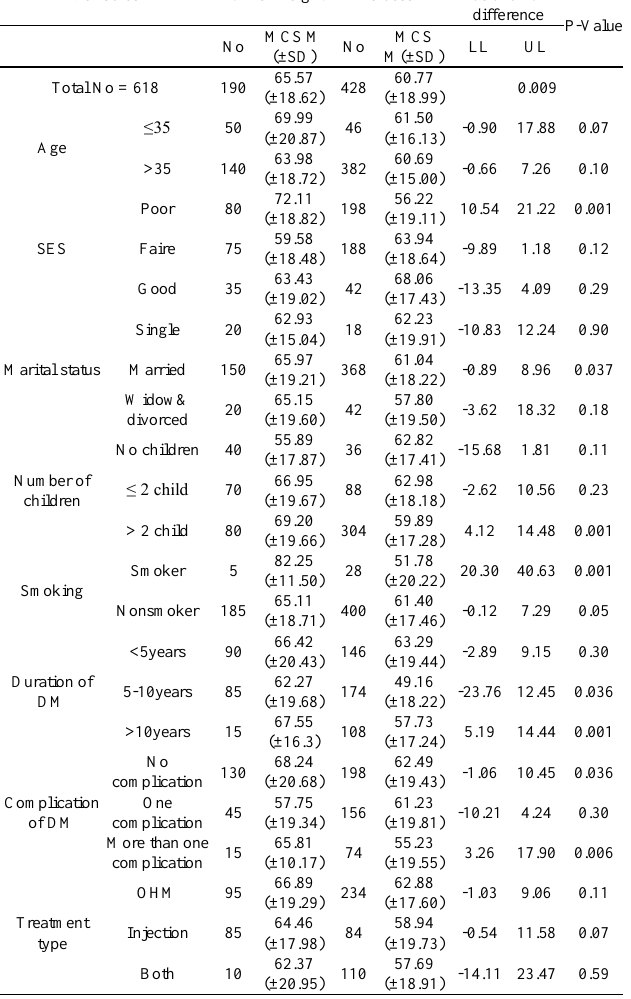
Table 6 : The difference between Mental Component Summary scores Mean (±SD) scores in obese and normal weight women according to study